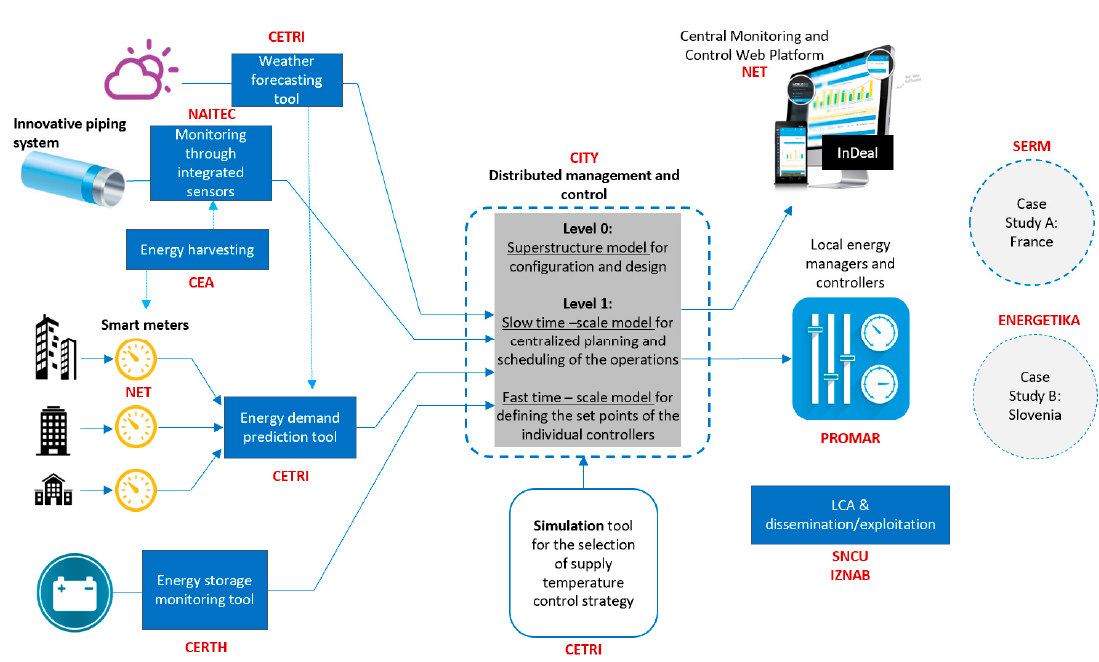
Figure 1. The integrated InDeal solution.